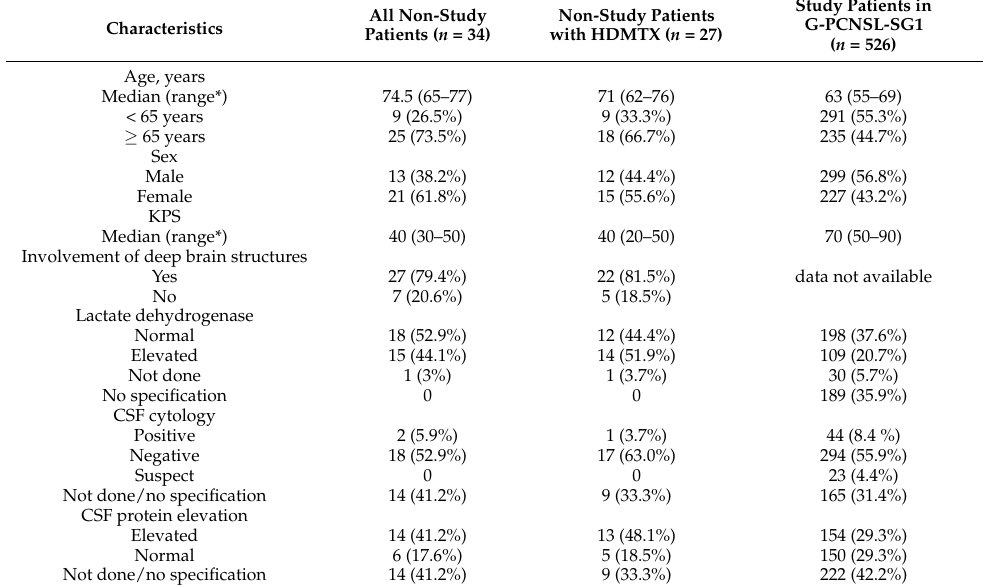
Table 2. Patient